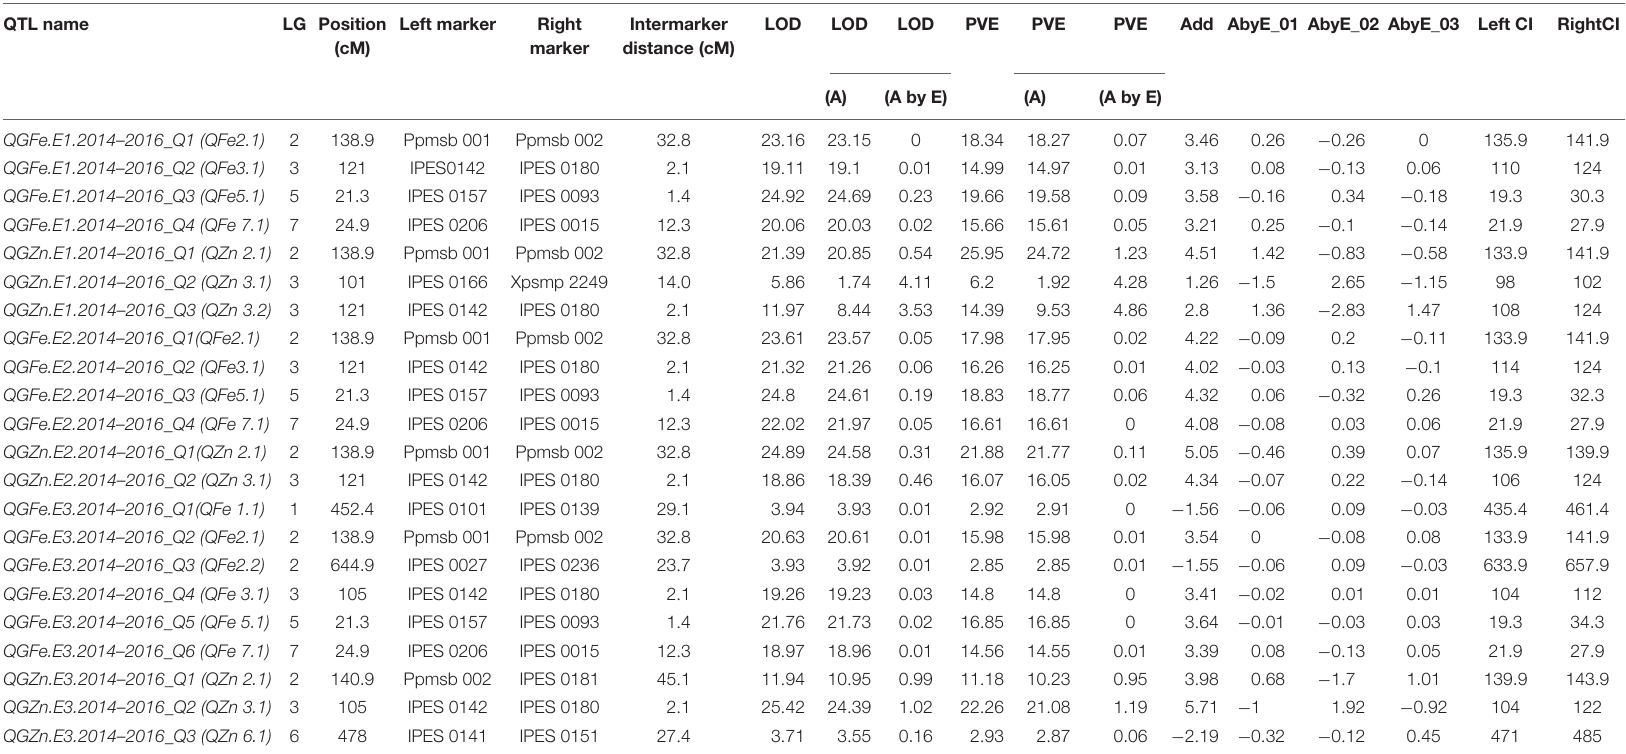
TABLE 8 | Quantitative trait loci for grain Fe (GFe) and Zn (GZn) content in RIL over three